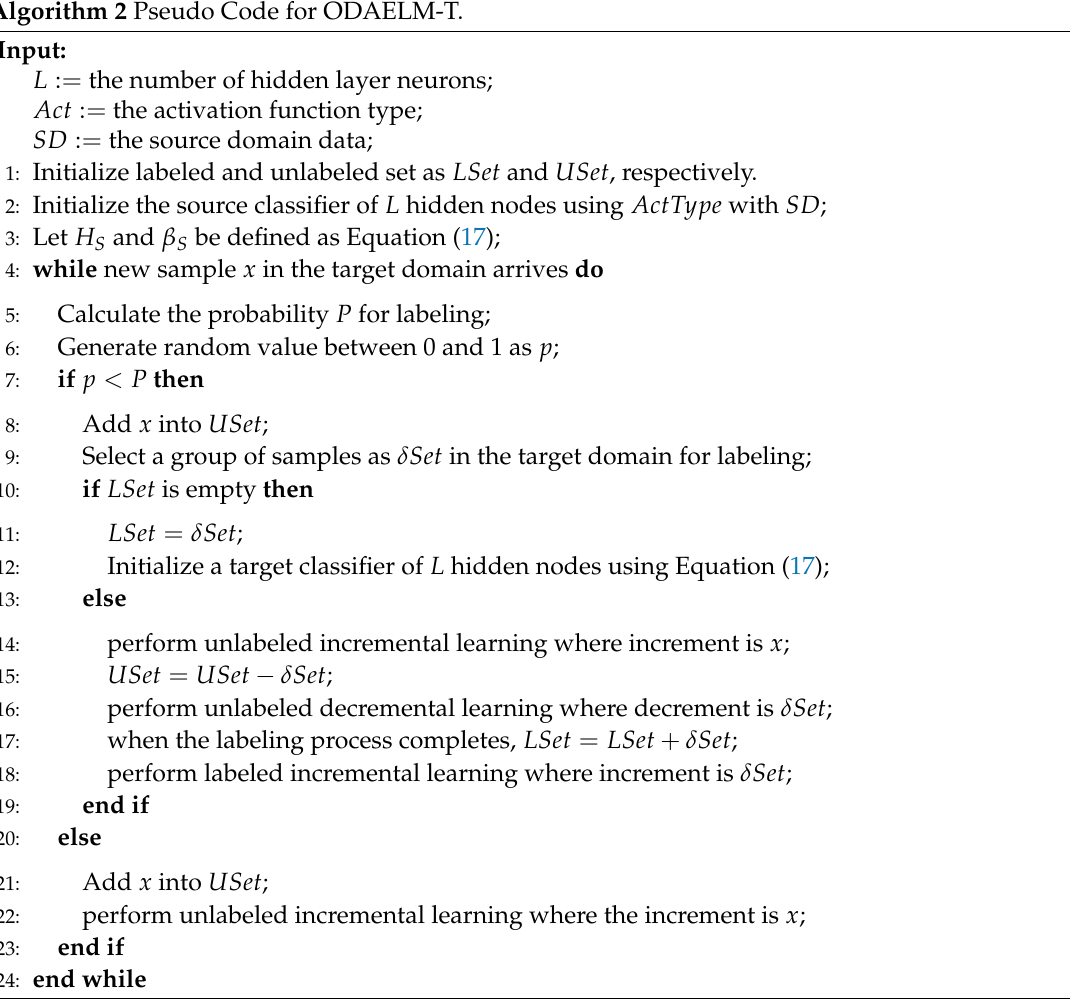
Algorithm 2 Pseudo Code for